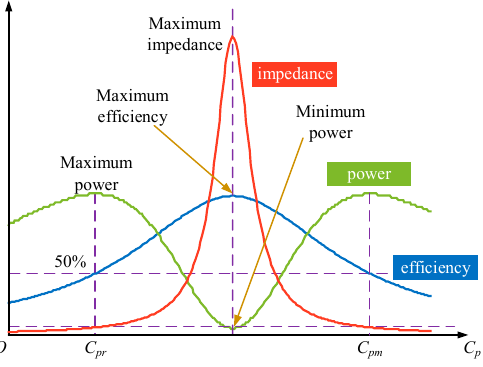
Figure 3. Relationship among equivalent impedance, power efficiency and C p .